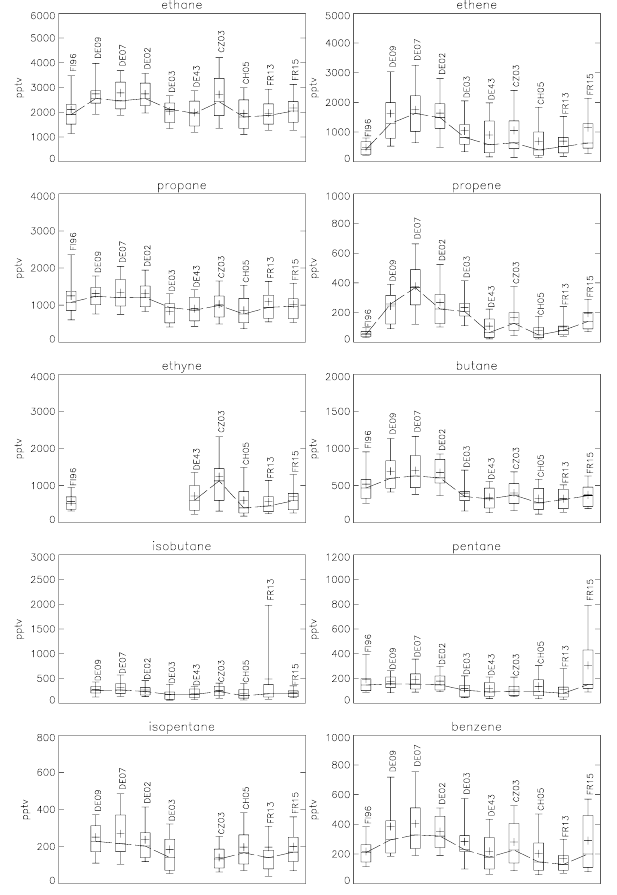
Fig. 13. Box- and whisker-diagrams for hydrocarbons measured at EMEP sites (Appendix A) satisfying the data requirements during winter 2009 (January, February, November, December). The mark- ers indicate the 10-, 25-, 50-, 75- and 90-percentiles. Mean values are indicated by a cross. The dashed line connects the median values for clarity. Unit: